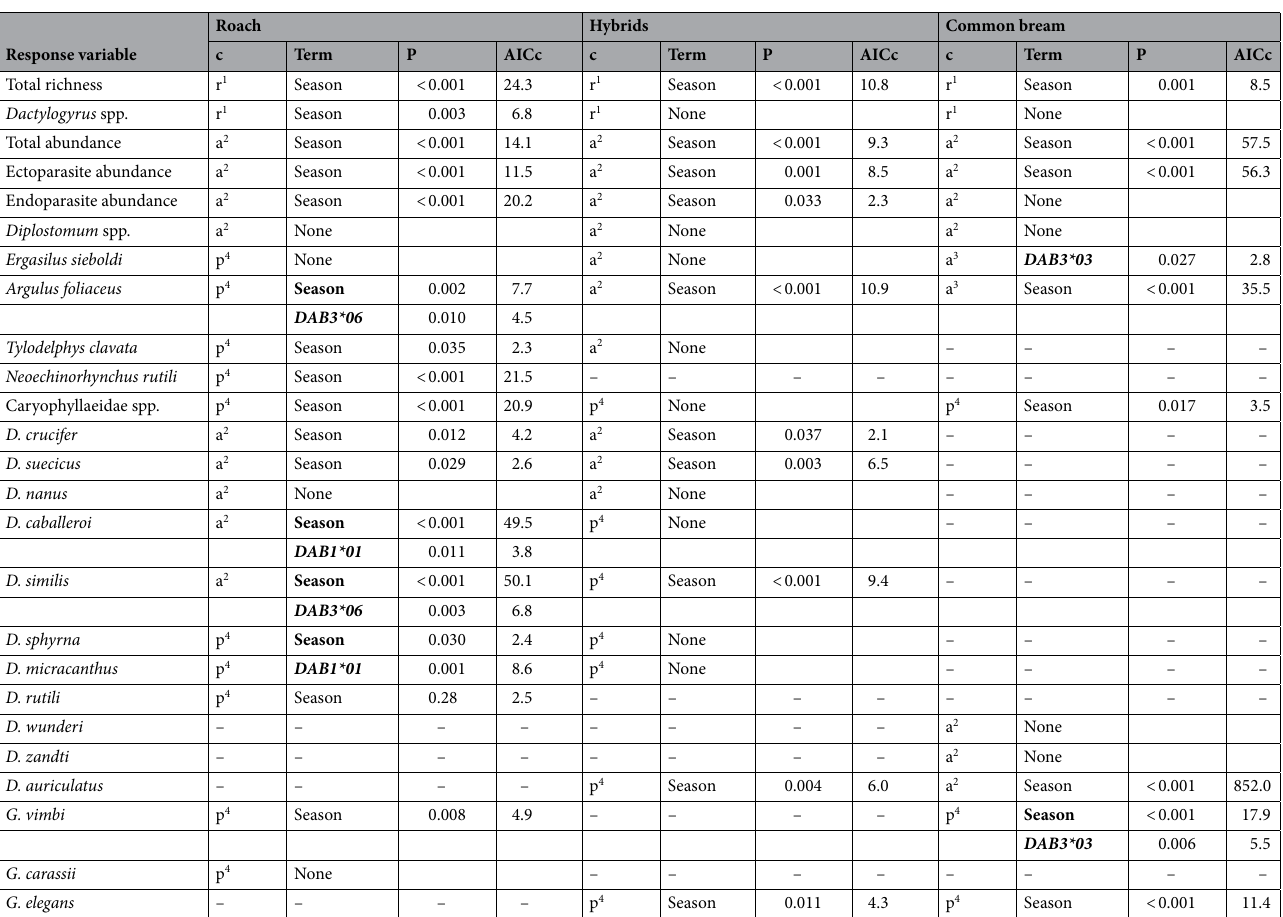
Table 5. Predictors remaining in final models originating by backward stepwise regression from GLMMs detecting effects of season and most common DAB alleles on attributes describing parasitofauna of roach, common bream and their hybrids (richness, abundance or, in case of prevalence < 30%, prevalence was used instead of abundance). Terms of models where number of alleles played a role are in bold. c = characteristic studied: r = richness, a = abundance, p = prevalence; distribution as specified in the model: 1 Poisson, 2